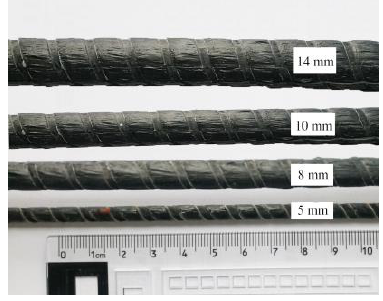
Figure 2. CFRP tendon (mm).